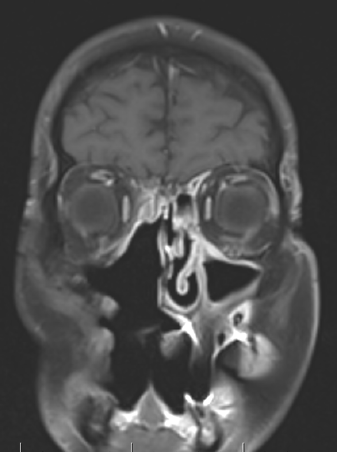
Figure 6. Follow-up MR imaging demonstrates a postresection cavity without tumour residue or recurrence in the right maxilla (5 years after surgical treatment). Axial imaging in T2 weighting.